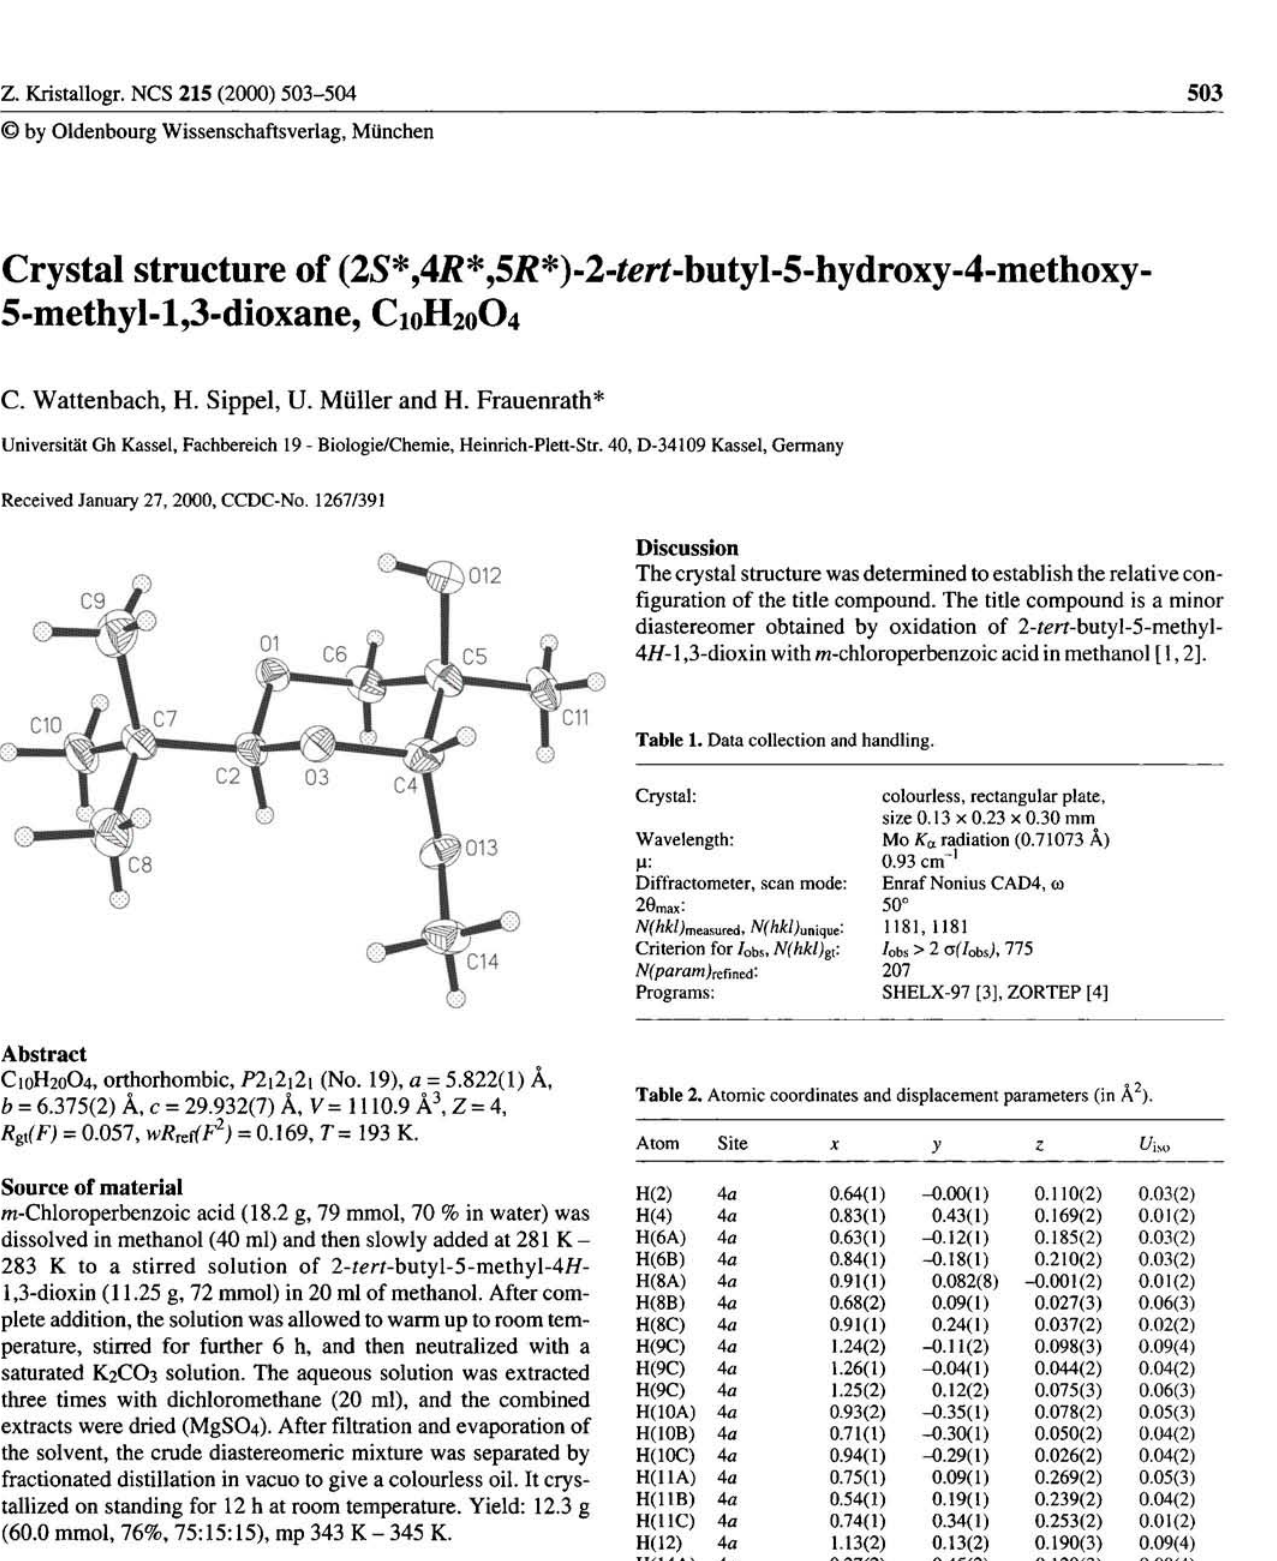
Table 2. Atomic coordinates and displacement parameters (in Â 2